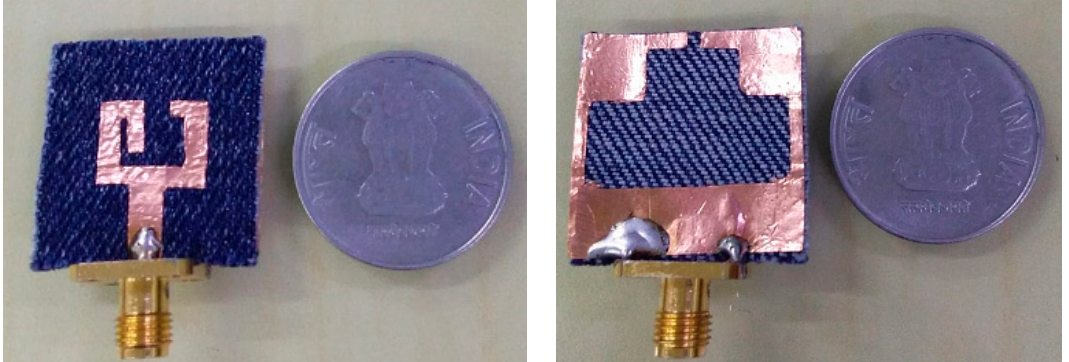
Figure 7. Fabricated textile antenna front and back view.